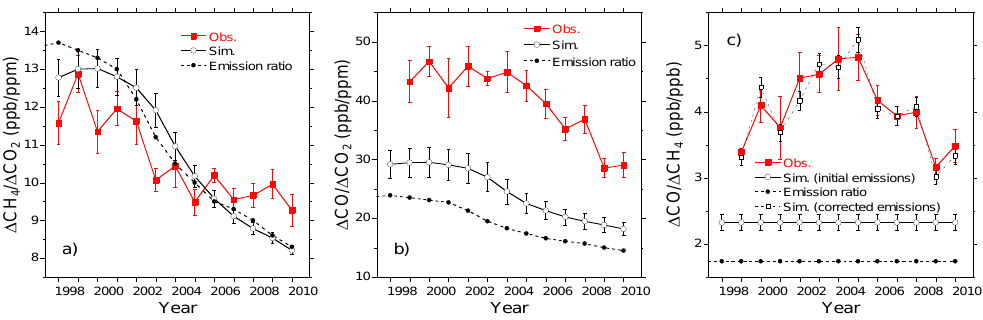
Fig. 7. Temporal changes in the winter average correlation slopes of (a) 1 CH 4 / 1 CO 2 , (b) 1 CO/ 1 CO 2 , and (c) 1 CO/ 1 CH 4 . The red closed squares represent the observation and the open circles represent the simulation. The error bars represent the standard errors. The ratios of the emissions within EFA are also depicted as closed circles. The black open squares in Fig. 7c represent the 1 CO/ 1 CH 4 slopes based on the optimized CH 4 and CO emissions from China within EFA (see